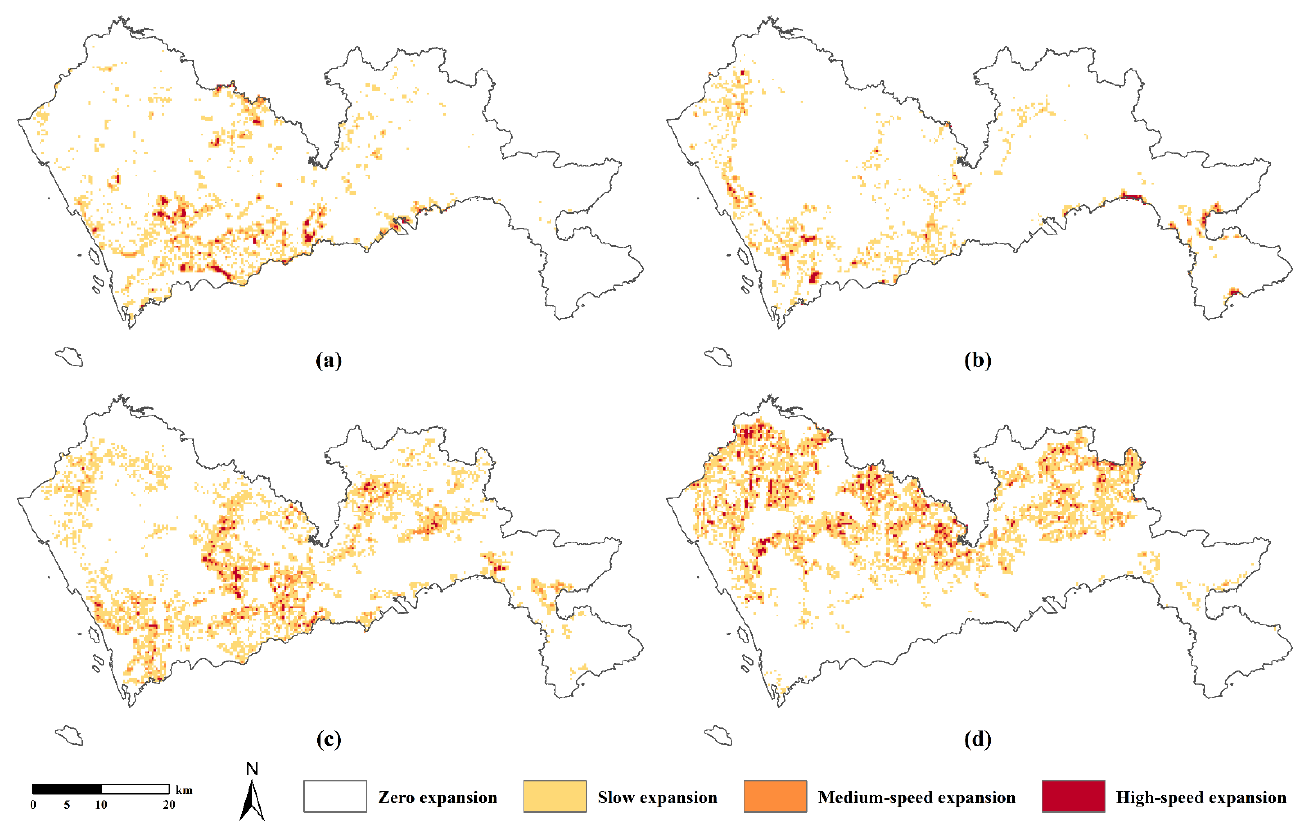
Figure 14. Spatial distribution of urban 3D expansion intensity of urban land use types in Shenzhen, 2014 – 2034. (a) public management services land; (b) commercial land; (c) residential land; (d) industrial land.